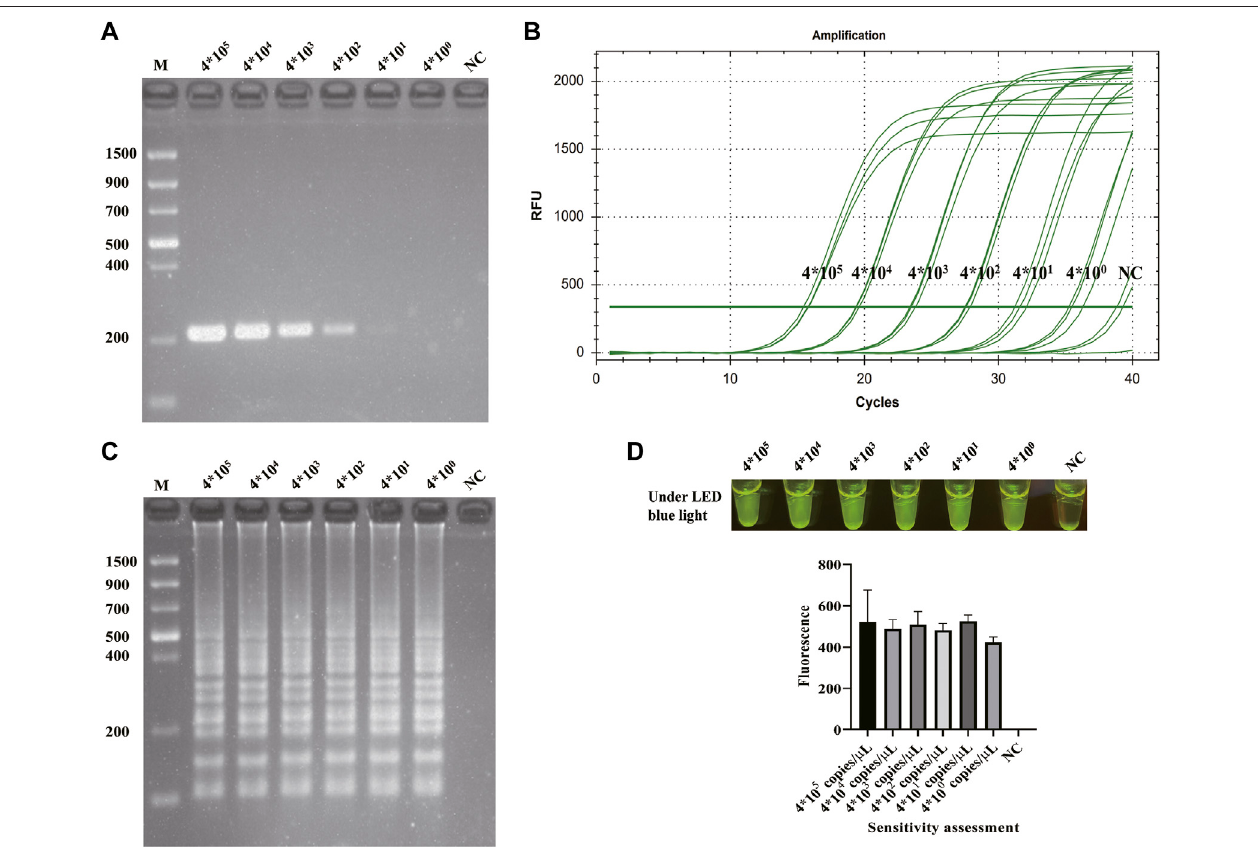
FIGURE5| SensitivityevaluationofCRISPR/Cas12a-E-LAMP.ThesensitivityofCRISPR/Cas12a-E-LAMPwascomparedwithPCR,qPCR,andLAMP.Theserial 10-fold dilutions of S. fl exneri -recombined plasmids (4*10 5 − 0 copies/ μ l) were used for the sensitivity evaluation. The sensitivity evaluation results of PCR and LAMP were shown by agarose gel electrophoresis. The sensitivity evaluation results of qPCR and CRISPR/Cas12a-E-LAMP were shown by the real-time ampli fi cation curve, endpoint fl uorescence photography, and endpoint fl uorescence intensity. (A) The sensitivity evaluation of PCR. (B) The sensitivity evaluation of qPCR. (C) The sensitivity evaluation of LAMP. (D) The sensitivity evaluation of CRISPR/Cas12a-E-LAMP. NC, negative control.